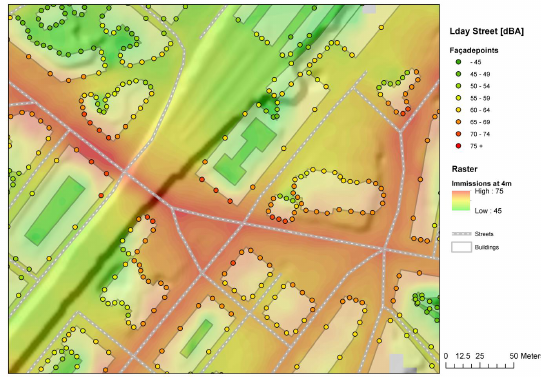
Fig. 6. Noise map and exposure at façade points of road traffic for the period of 06:00-18:00 (L Day